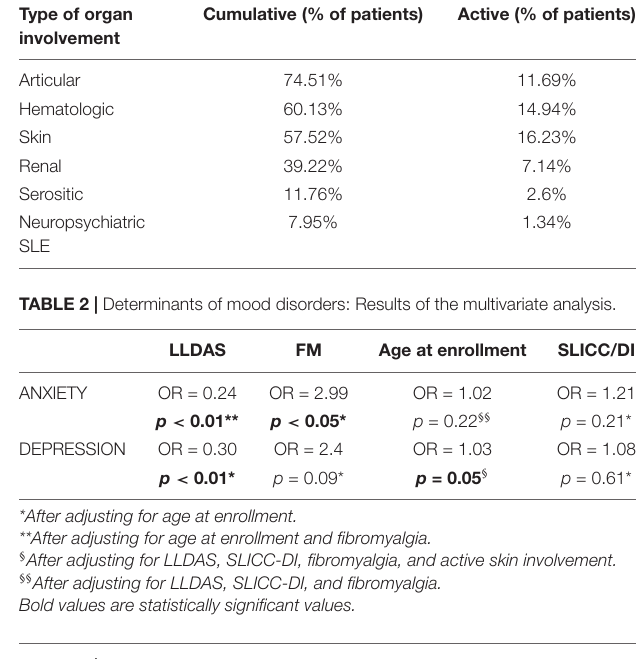
TABLE 3 | Correlation between HADS and other